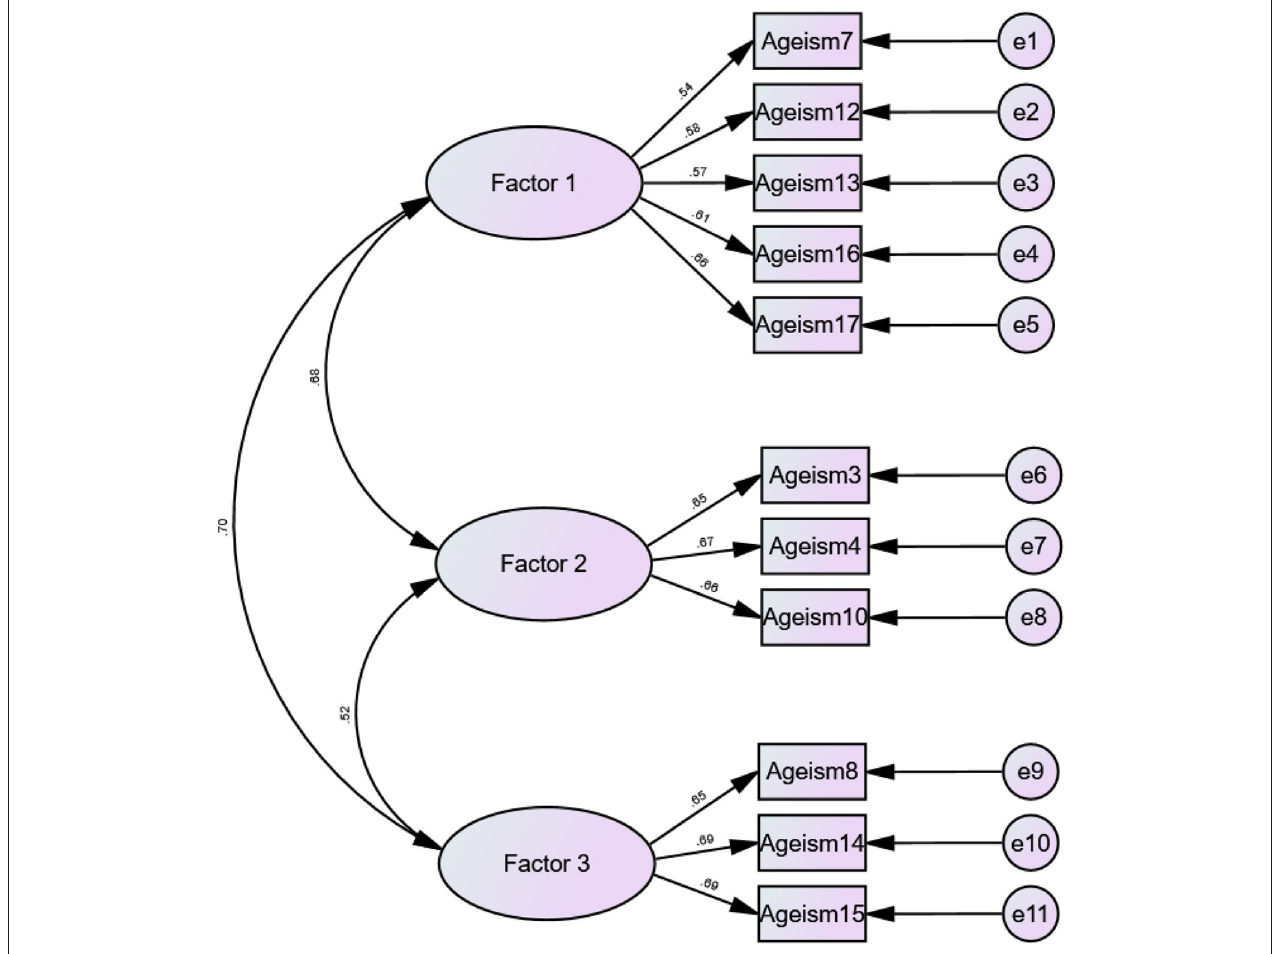
FIGURE 2 | Confirmatory factor analysis on the results obtained from EFA ( N = 200).